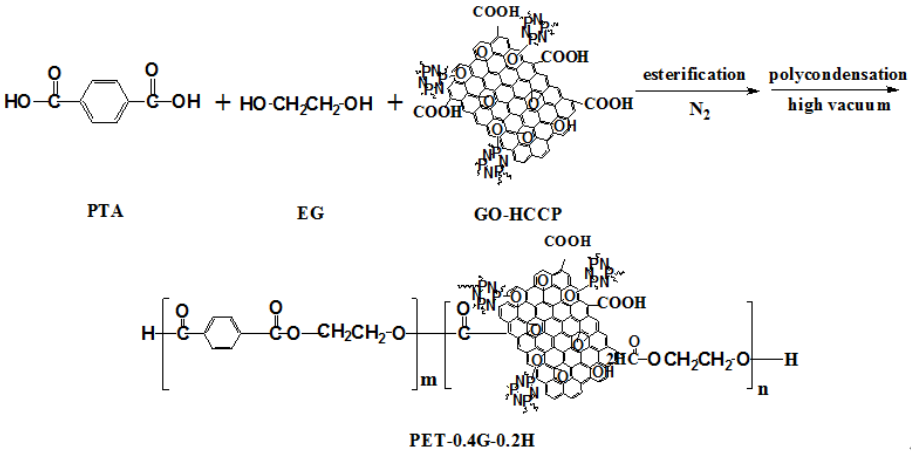
Figure 2. The preparation route of PET-0.4G-0.2H.